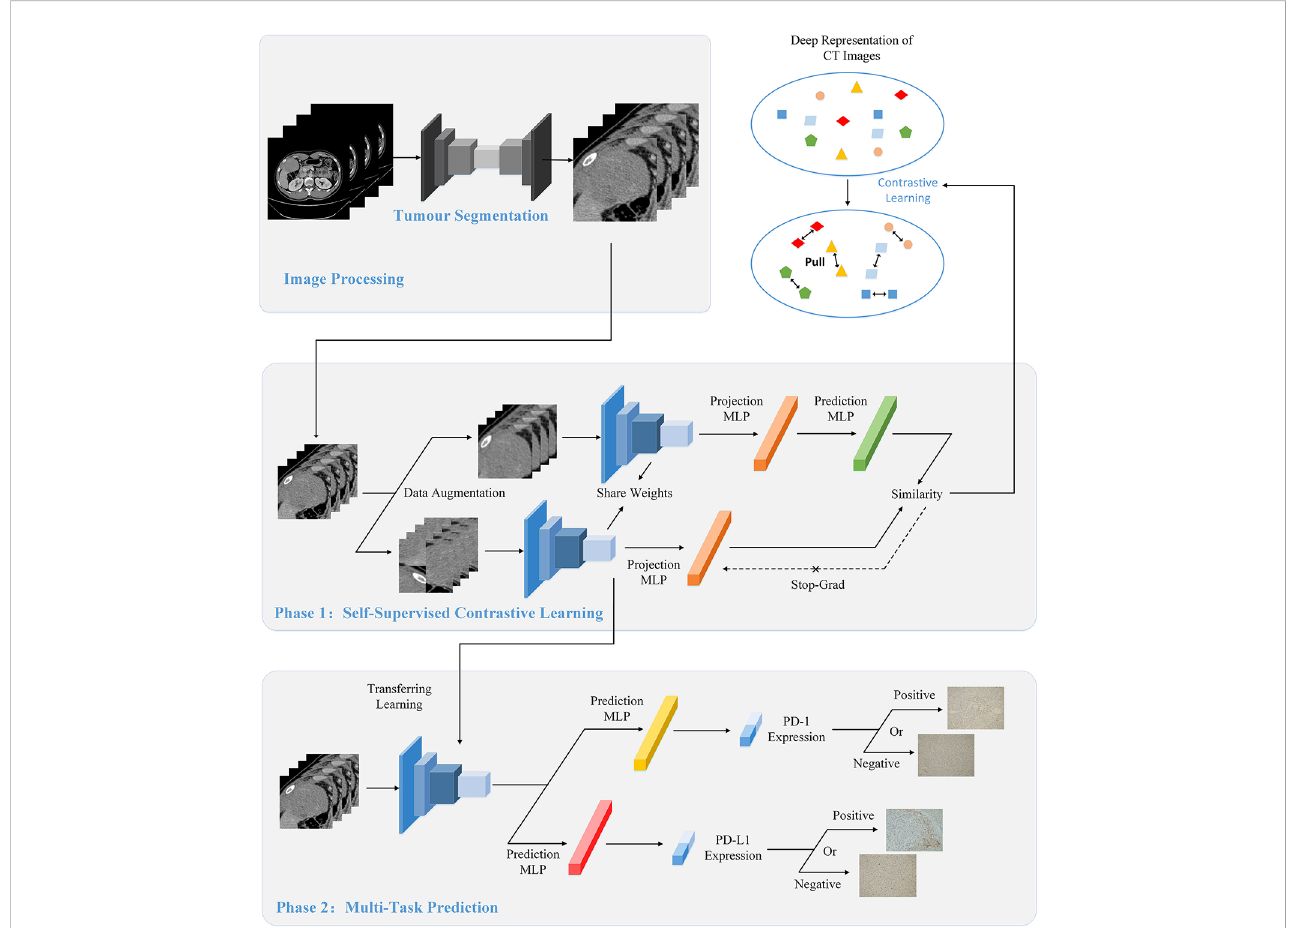
FIGURE 1 The overall fl ow of image processing, self-supervised contrastive learning, and multi-task prediction. (Top) During the image processing stage, we extracted the tumor regions from the original CT images as the input of the model using the segmentation network. (Middle) We used contrastive learning to pre-train the proposed CLNet. A series of data augmentation strategies were used to produce two different views of the same image, and contrastive learning would improve the model ’ s ability by gathering the two different views. Besides, we added additional unlabeled CT images to the train set to increase the data patterns and improve the generalization of the model. (Bottom) We applied the model pre-trained with contrastive learning as the backbone model and used the transfer learning strategy to train the prediction model. Two independent Multilayer Perceptrons (MLP) were added for predicting PD-1 and PD-L1 expressions